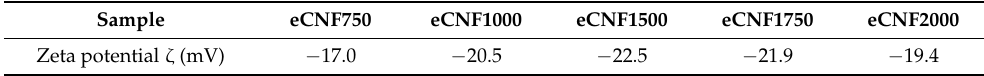
Table 2. Zeta potential results of the eCNF samples in a PBS solution at pH = 7.2.